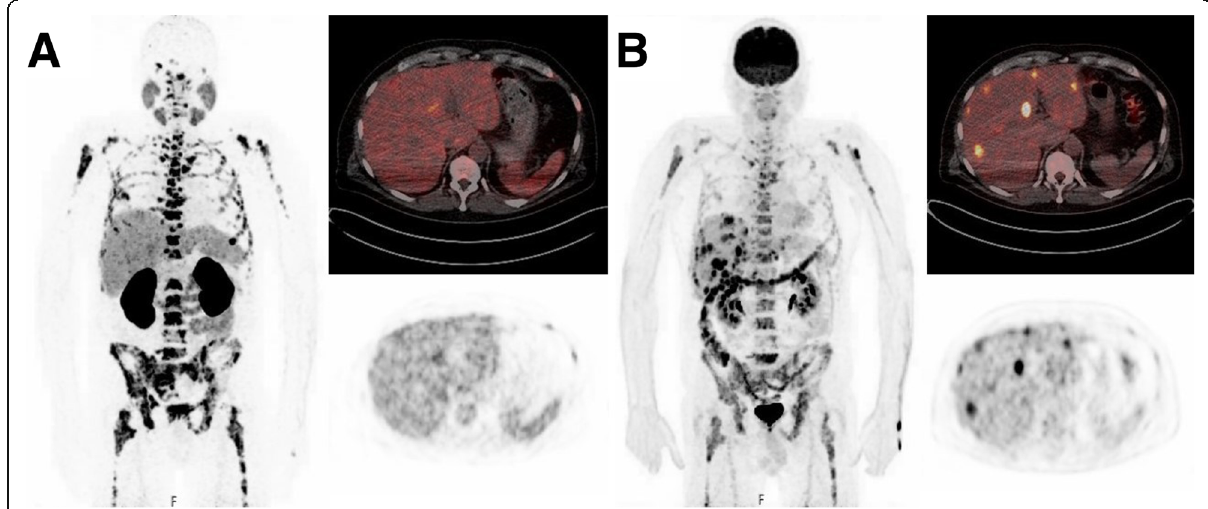
Fig. 1 Patient with hepatic mismatch findings. Maximal intensity projection (MIP), PET/CT, and PET data of [ 68 Ga]Ga-PSMA-11 PET/CT ( a ) and of [ 18 F]FDG PET/CT ( b